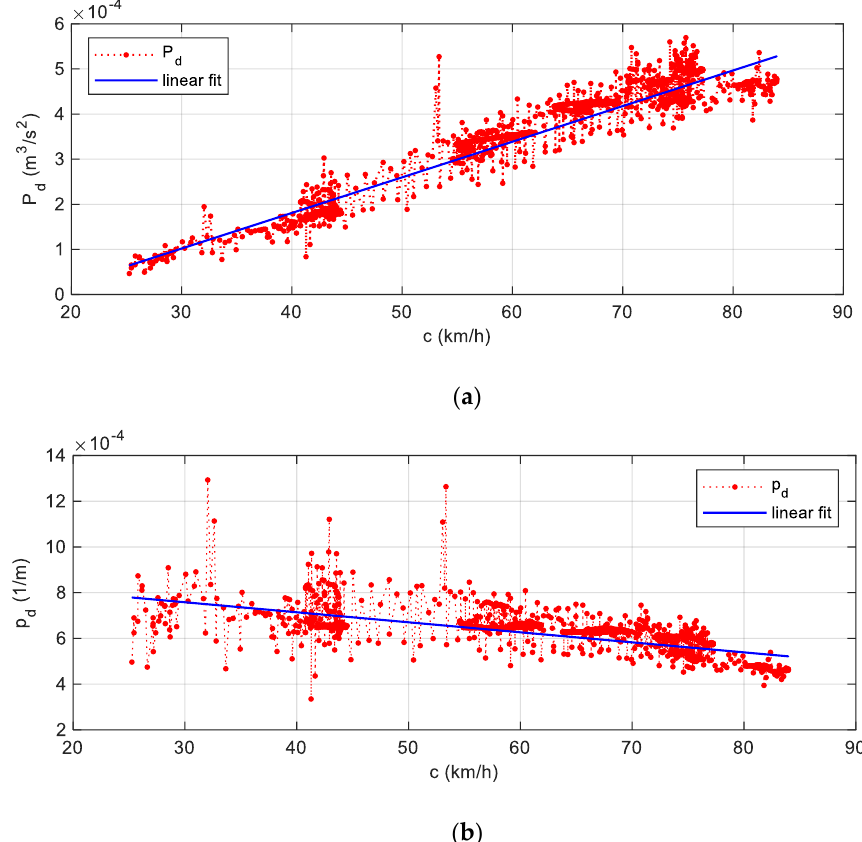
Figure 12. ( a ) The moving averages of the specific dissipated power P d evaluated in Figure 11a, sorted in ascending order in respect of the tyre velocity, along the x-axis; ( b ) the moving averages of the dissipation factor p d evaluated in Figure 11b, sorted in ascending order in respect of the tyre velocity, along the x-axis.